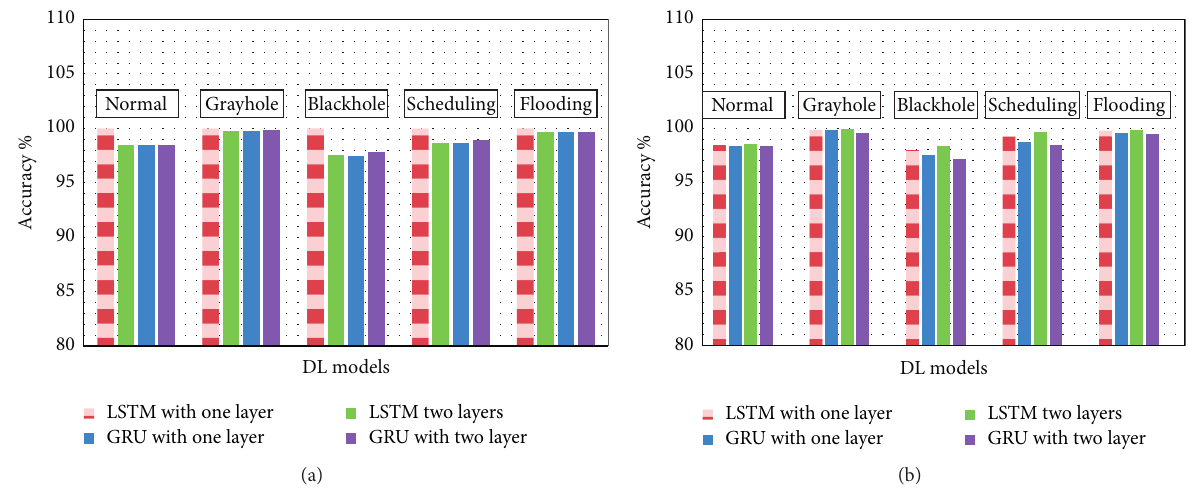
Figure 8: The results of deep learning testing performance for WSN dataset: (a) accuracy using all features and (b) accuracy using selected features.